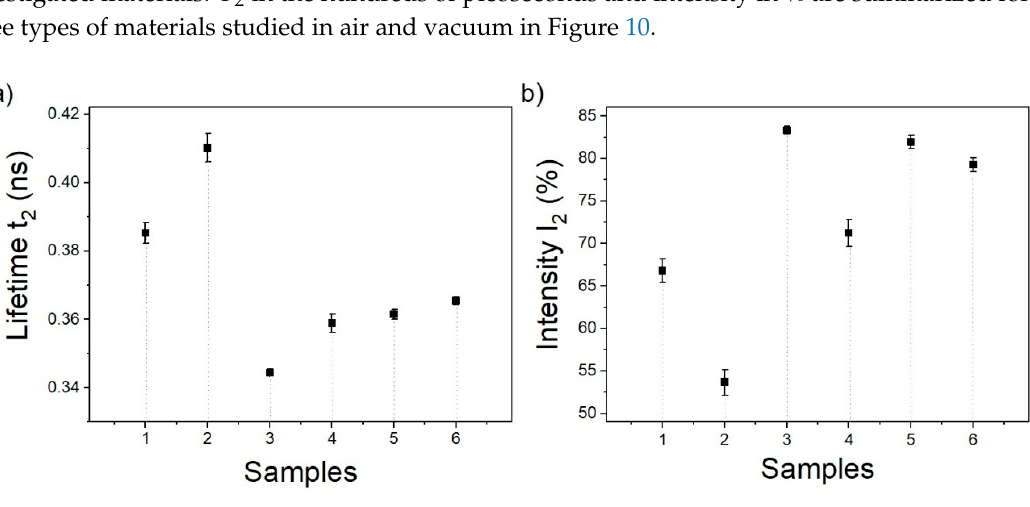
Figure 10. Lifetime t 2 ( a ) and the relative intensity I 2 ( b ) for the CCP, rhodamine B, and their composite.